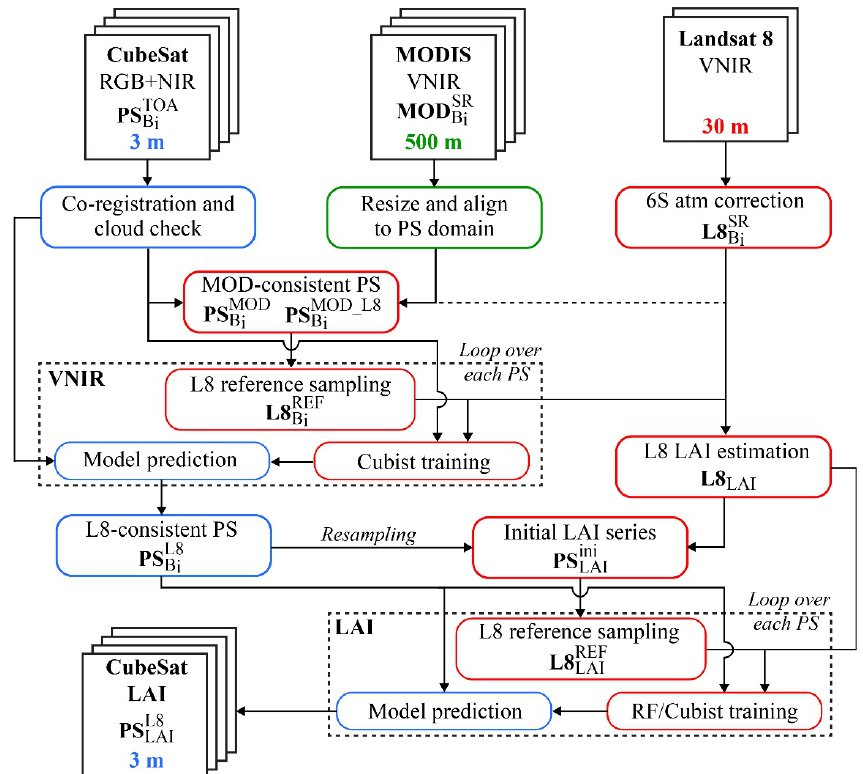
Figure 2. Overview of CESTEM processing steps for producing Landsat 8 (L8) consistent multispectral and LAI information at the spatial and temporal resolution of the PlanetScope (PS) CubeSat data. Box colors indicate the spatial data resolution (i.e., native or resampled) at each processing step. See Section 2.4 for a detailed description of the methodology and parameter definitions.